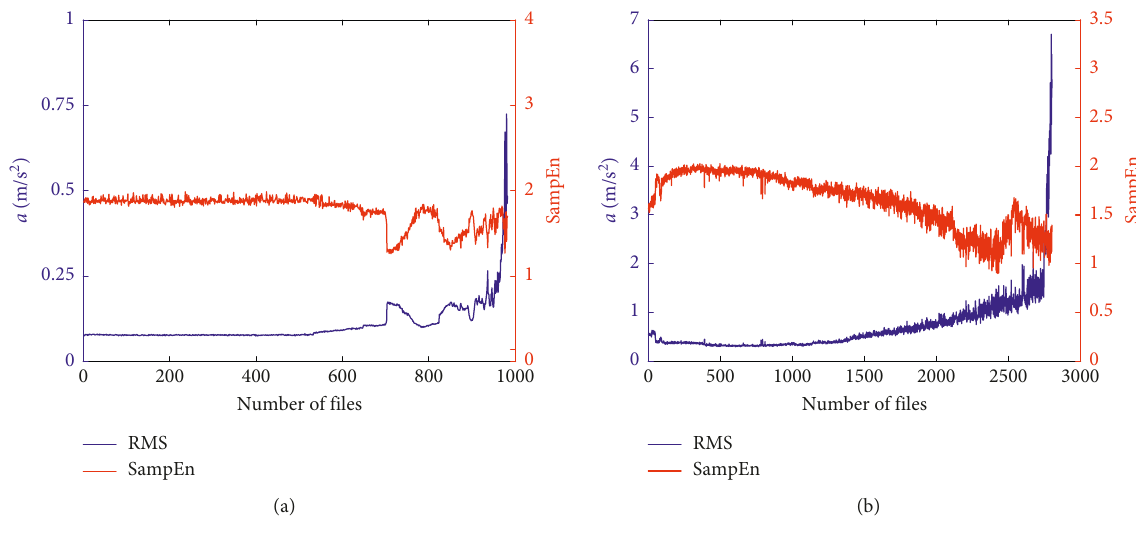
Figure 24: The SampEn and RMS of (a) Case I and (b) Case